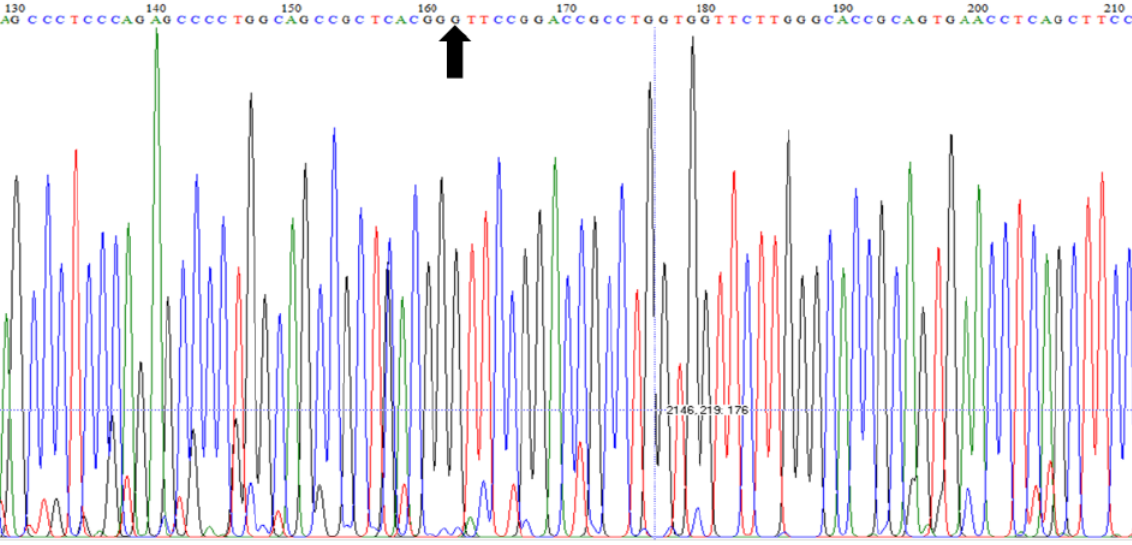
Figure 3: Partial DNA sequencing chromatograms of ABO gene of A 2 –related alleles identified by direct sequencing. In sample 1, the arrow indicated the 1061C nucleotide at rs 8176750 that was not